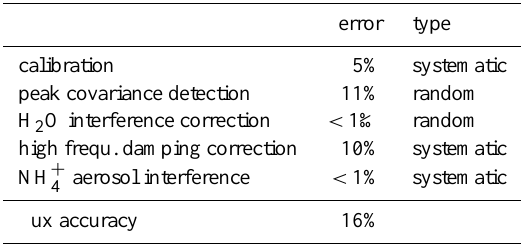
Table 3. Estimated individual errors and error types potentially in- fluencing the flux